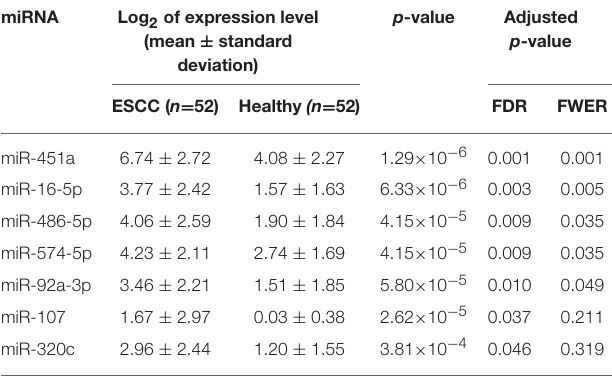
TABLE 2 | The seven selected miRNAs by controlling FDR and